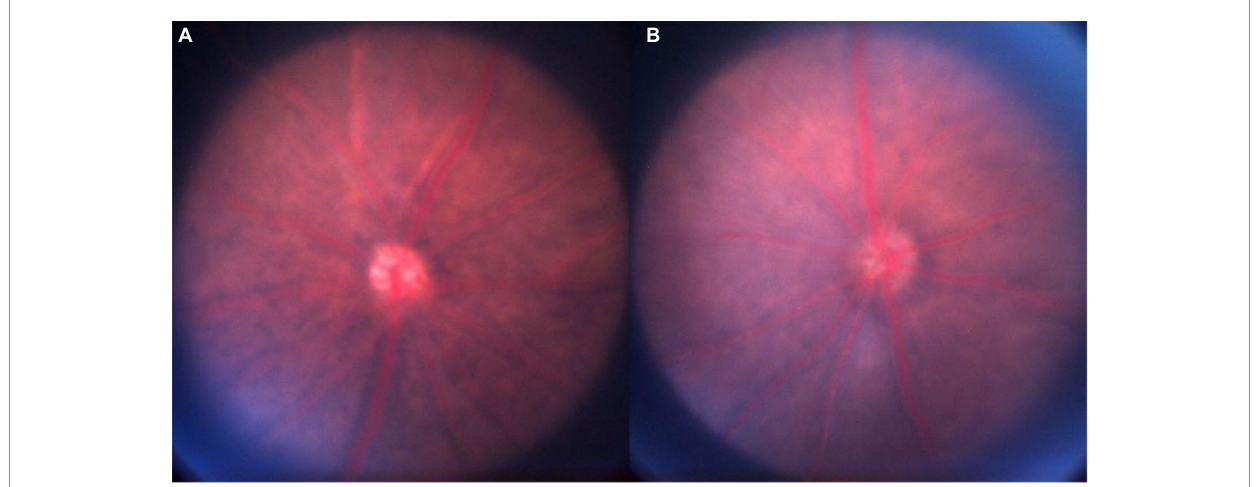
FIGURE 2 Fundus imaging. Notes: (A) : FDM-OD; (B) : FDM-OS. FDM: form-deprivation myopia; OD: oculus dexter; OS: oculus sinister.